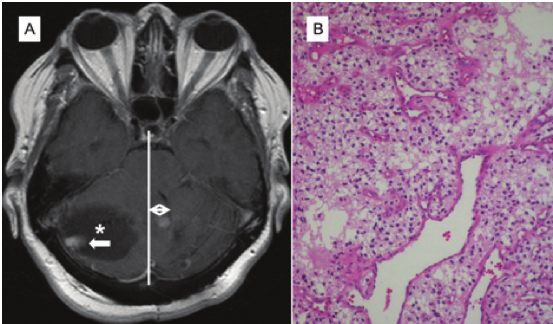
Figure 1. (A) Axial T1 postcontrast images demonstrate an enhancing mural nodule (white arrow) with accompanying cyst (*) in the right cerebellar hemisphere exerting a mass effect upon the midline and fourth ventricle (double white arrow). (B) Hematoxylin-eosin staining showing scattered large hyperchromatic nuclei, vacuolated cells, and multiple capillaries which are classic features of the cellular type of